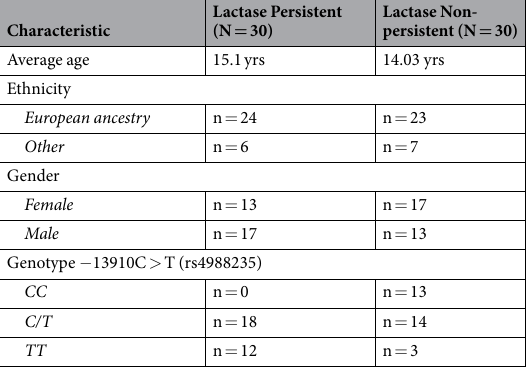
Table 1. Characteristics of study population used in DNA methylation analysis by Infinium 450K methylation microarray and Pyrosequencing including outlier